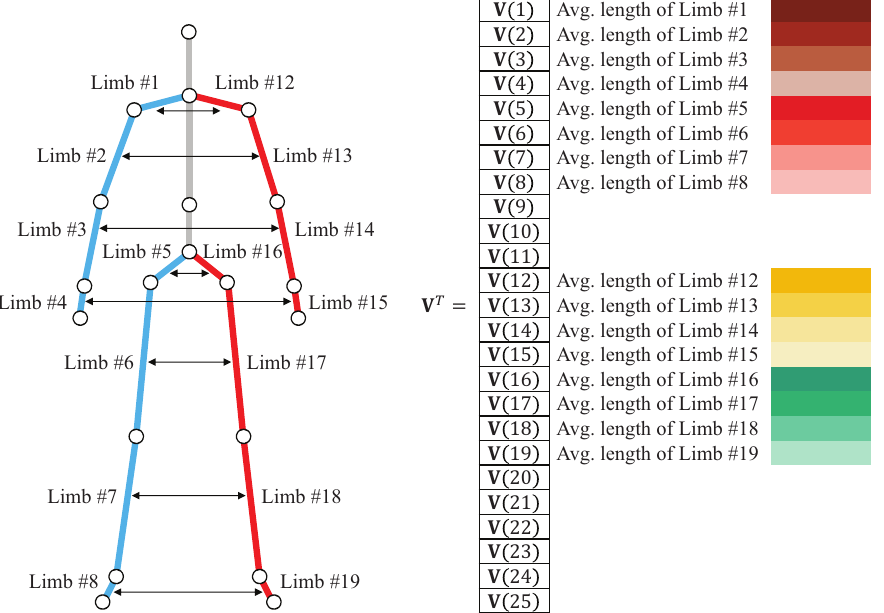
Figure 7. V ( t ) for the t th element is indicated in its symbol